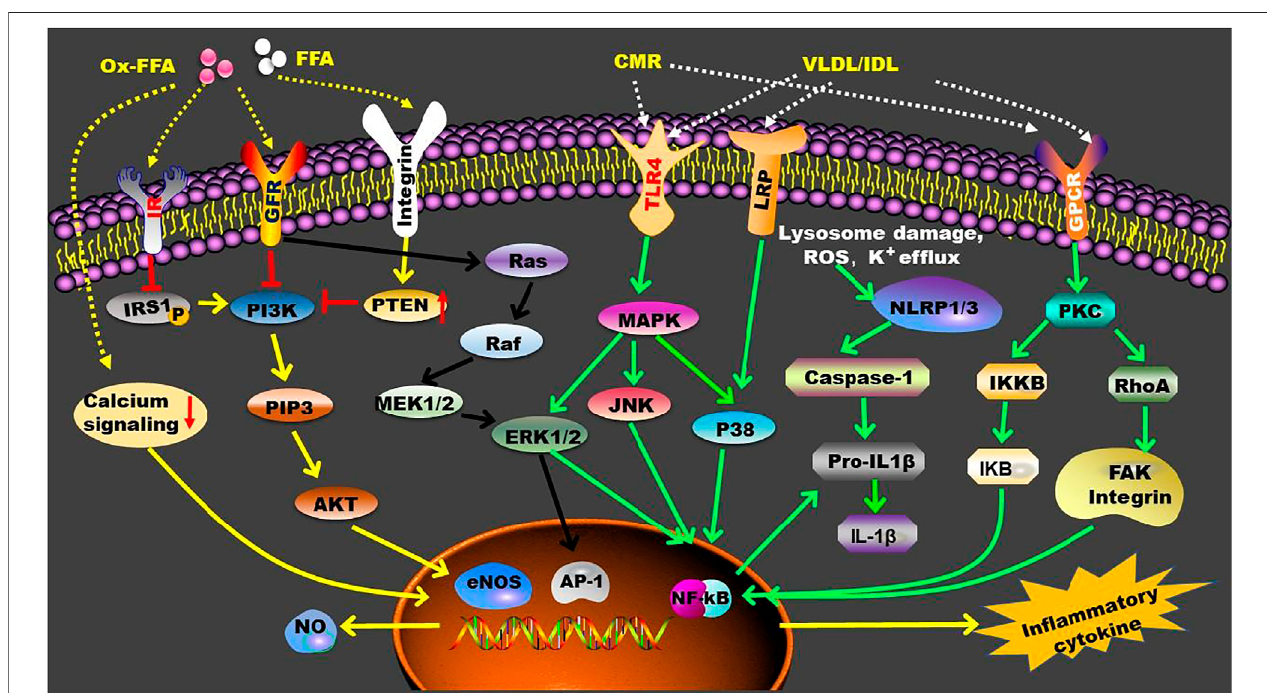
FIGURE3| TGRLandTGRLmetabolites-mediatedin fl ammatorysignalingpathways.Incirculation,LPLconvertsTGRLtoTGRLremnants,suchasCMRandIDL, and promotes the production of FFA. These TGRL metabolites enhance in fl ammation by activating multiple receptors that located on the cell membrane. Furthermore, FFAcanpenetratecellmembraneandexerttheirfunctionsintracellularly.AP-1,activatingprotein-1;eNOS,endothelialnitricoxidesynthase;ERK1/2,extracellularsignal- regulated kinase 1/2; FAK, focal adhesion kinase; FFA, free fatty acid; GFR, growth factor receptor; GPCR, G protein-coupled receptor; IKB, nuclear factor-kappa B inhibitor; IKKB, Inhibitor of kappa B kinase; IL-1 β , interleukin-1 β ; IR, insulin receptor; IRS1, insulin receptor substrate 1; JNK, c-Jun NH2-terminal kinase; LRP, LDL receptor-related protein; MAPK, mitogen-activated protein kinase; MEK1/2, mitogen-activated protein kinase kinases 1/2; NF-kB, nuclear factor-kappa B; NLRP, nucleotidebindingdomainlikereceptorfamilypyrroledomaincontainingprotein;NO,Nitricoxide;P38,P38mitogen-activatedproteinkinase;PI3K,phosphoinositide3- kinase; PIP3, phosphatidylinositol 3,4,5-trisphosphate; PKC, protein kinase C; PTEN, phosphatase and tensin homolog; RhoA, Ras homolog family member A; TRL-4, Toll-like receptor